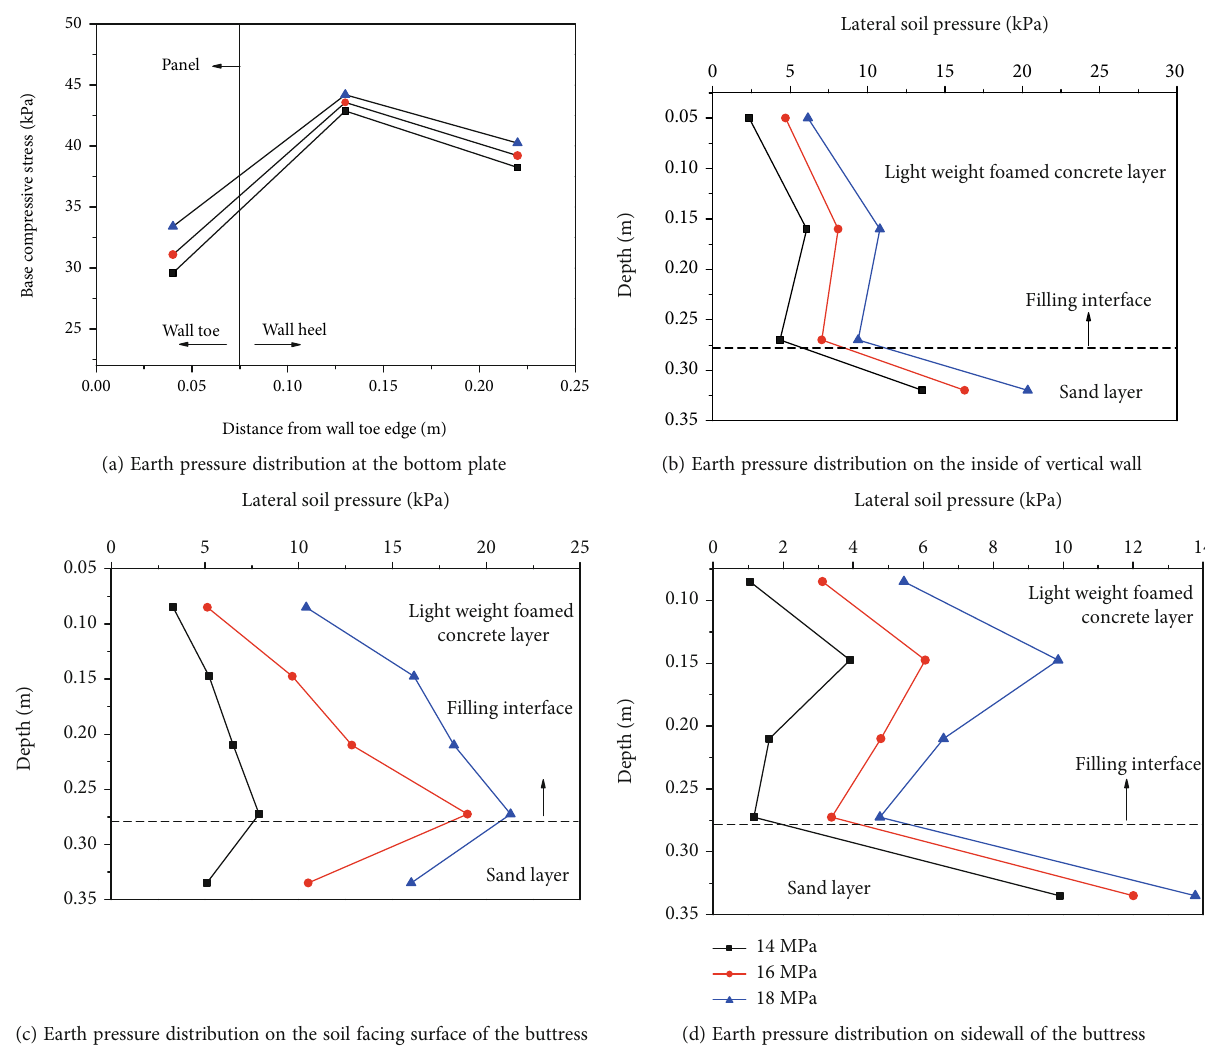
Figure 8: Earth pressure distributions of retaining wall under di ff erent